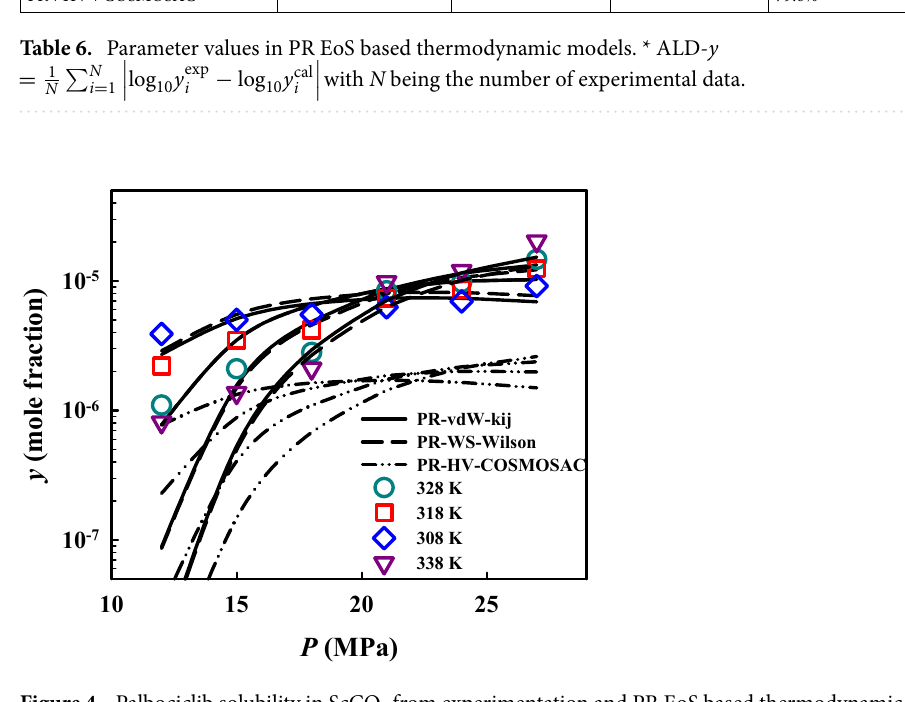
Figure 4. Palbociclib solubility in ScCO 2 from experimentation and PR EoS based thermodynamic